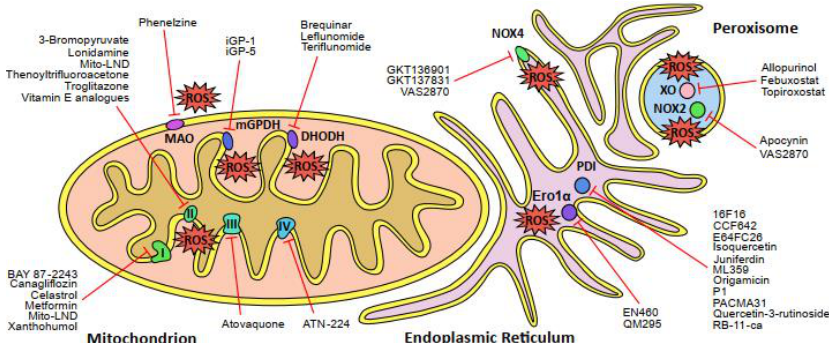
Figure 1. Schematic overview of the major sources of reactive oxygen species (ROS) in the cell and the corresponding inhibitors of those sites. The mitochondrial electron transport chain (ETC) complexes I, II and III generate ROS directly, whereas complex IV is the rate-determing step of the ETC. Other enzymes that produce ROS in the mitochondria are dihydroorotate dehydrogenase (DHODH), glycerol-3-phosphate dehydrogenase 2 (mGPDH or GPDH2) and monoamine oxidase (MAO). The endoplasmic reticulum (ER) comprises several sites of ROS production, such as NADPH oxidase 4 (NOX4) and the Ero1α-PDI oxidative protein folding pathway (Ero1α, ER oxidoreductin 1α; PDI, protein disulfide isomerase). Peroxisomes are another major source of cellular ROS production due to the activity of xanthine oxidase (XO) and NADPH oxidase 2 (NOX2). Names of pharmaceutical and experimental inhibitors are presented and the corresponding target sites of ROS production are indicated by red lines.